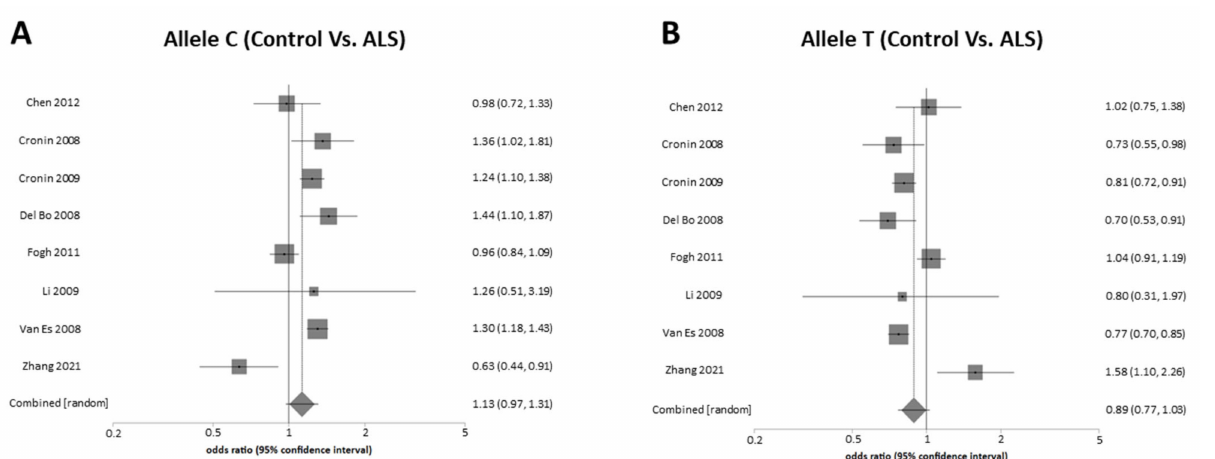
Figure 2. Forest plots reported no significant associations between single-nucleotide polymorphisms (SNP rs10260404) and risk of genotype for sporadic amyotrophic lateral sclerosis (SALS) from meta- analyses. The square size indicates the weight of each study and pooled data, together odds ratio and 95% confidence interval for the difference between control and cases with CC ( A ), CT ( B ), and TT genotype ( C ) between the SALS group and control group [38,41,46–48].